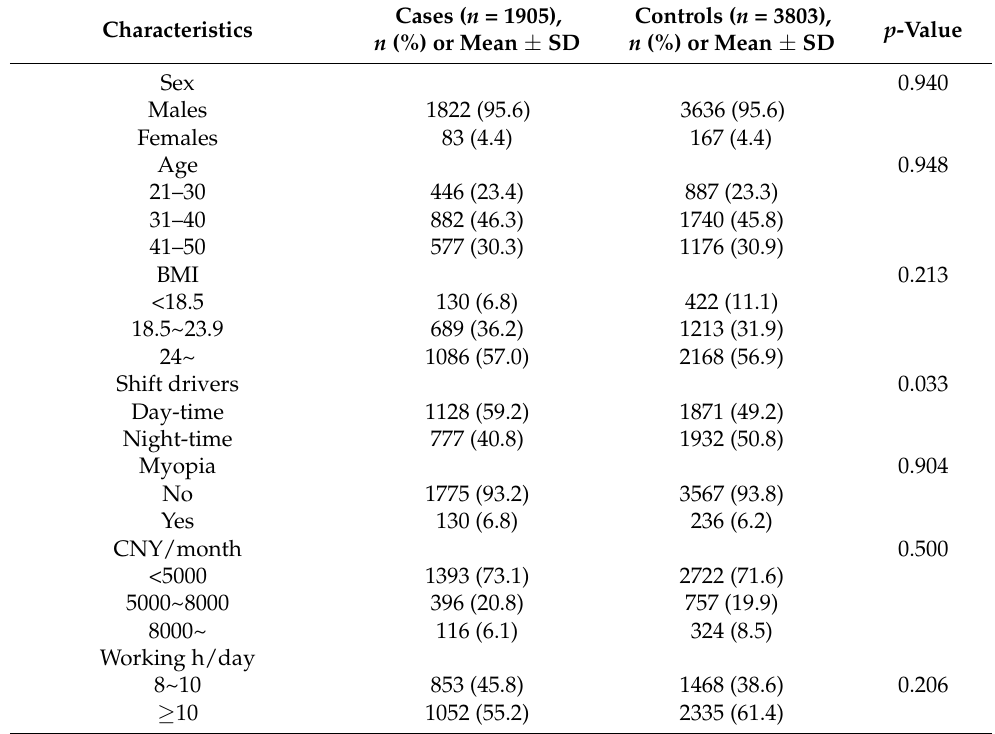
Table 2. Characteristics of taxi drivers with or without DED ( n = 5708).